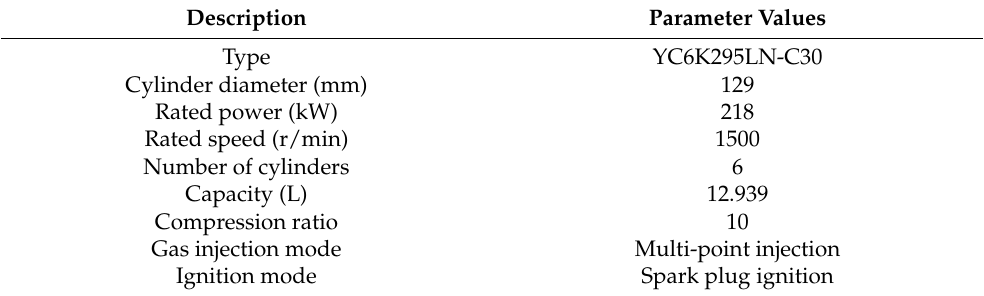
Table 1. Main engine parameters.